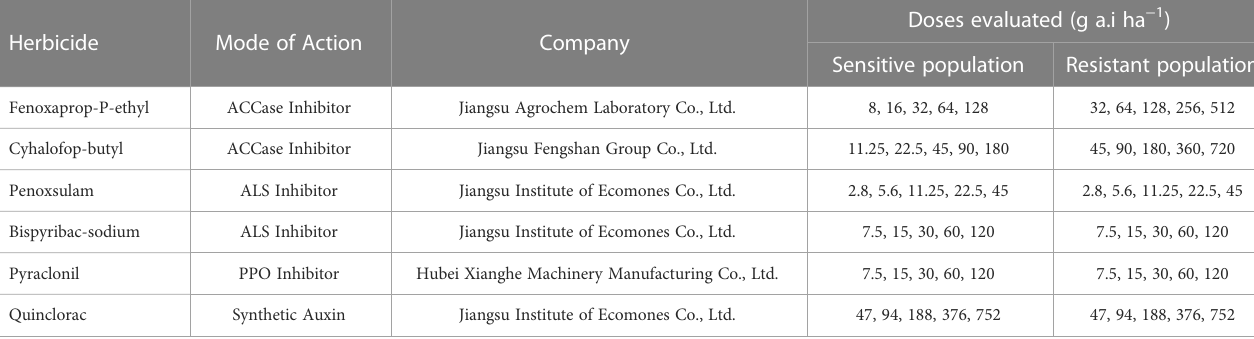
TABLE 3 Information for herbicides evaluated in this study.